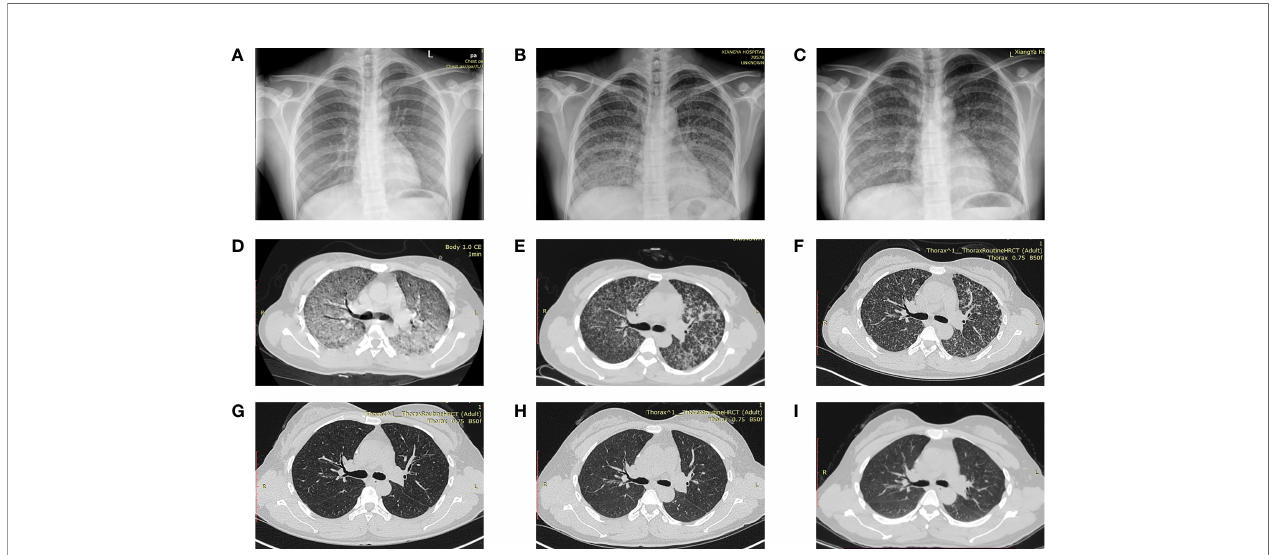
FIGURE 1 | Dynamic imaging changes of a 30-year-old pregnant woman diagnosed with miliary pulmonary tuberculosis after in vitro fertilization and embryo transfer (A) Normal chest X-ray in the routine exam before IVF-ET. (B) A massive and symmetrical ground-glass opacity in bilateral lungs 40 days after IVF-ET. (C) Decreased ground-glass opacity after antituberculosis treatment. (D) Diffuse ground-glass opacity and partial fusion, multiple nodules, and a small amount of pleural effusion in the right thorax and a calci fi cation nodule in the right middle lobe. (E, F) Resolution of miliary nodules after 1 and 2 months of antituberculosis treatment, respectively. (G – I) Nodules disappeared at 8 months and 1 and 3 years after treatment. IVF-ET, in vitro fertilization and embryo transfer.